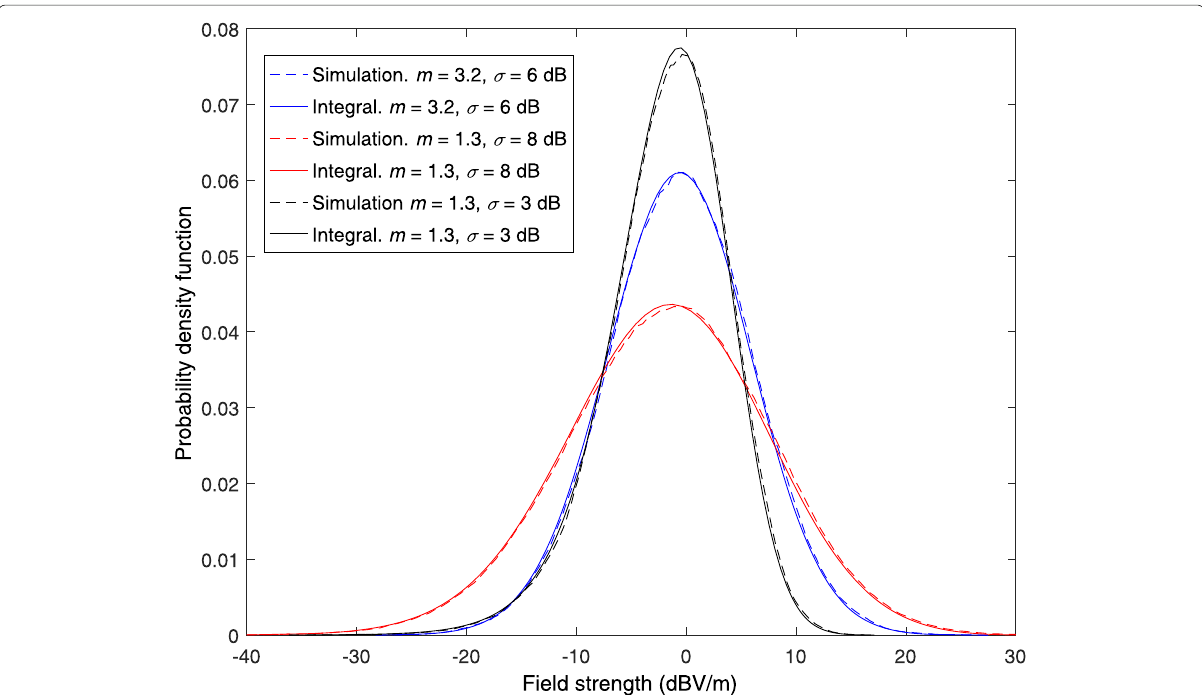
Fig. 3 Probability density functions of the Nakagami-lognormal distribution with m = 1.3, σ d = 3 dB; m = 1.3, σ d = 8 dB; and m = 3.2, σ d = 6 dB, respectively. Number of samples in the simulations, N = 100,000, and μ d = 0